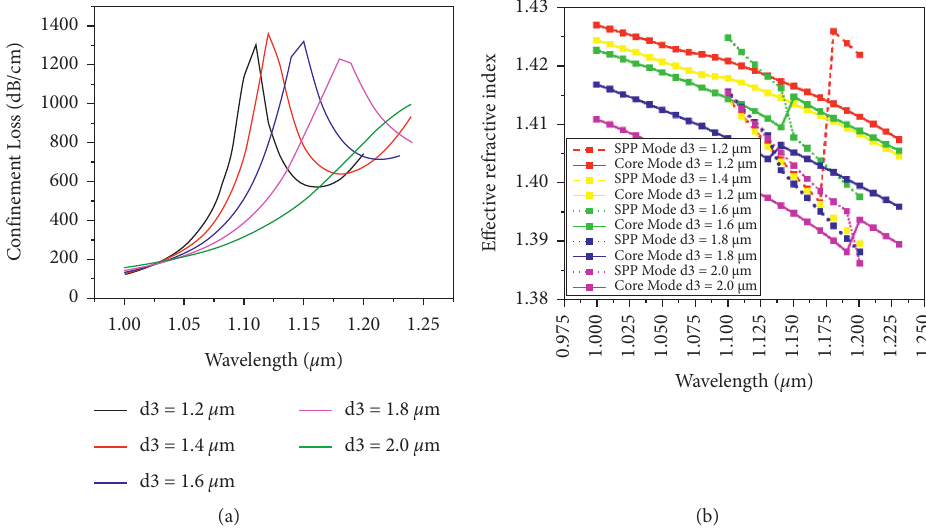
Figure 4: (a) Mode loss spectra and (b) the effective mode indices for various values of d t GOLD � 30nm.